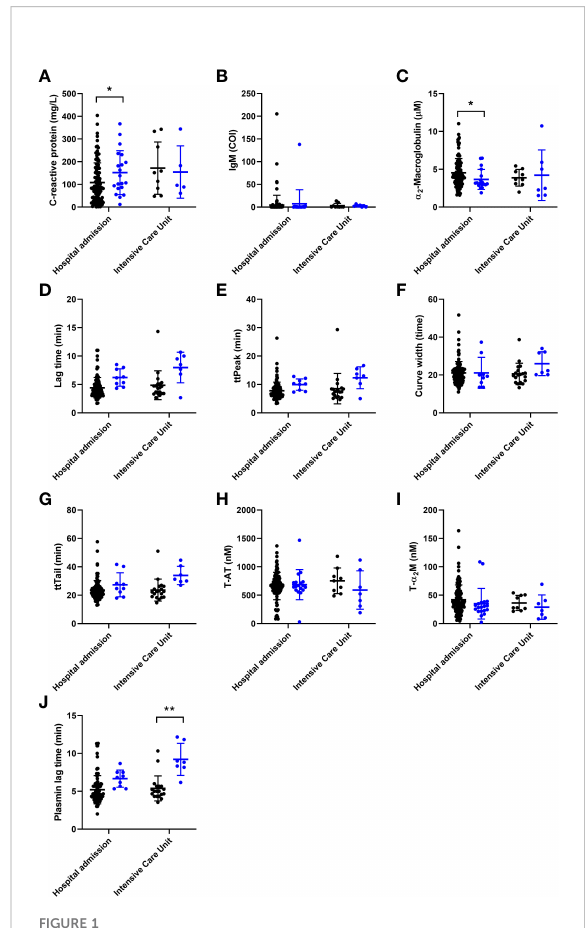
FIGURE 1 The individual association of coagulation and general (laboratory) parameters used for the development on a neural net for the prediction of thrombosis in COVID-19 patients, arranged from most to least important. Patients without thrombosis are depicted as black circles and patients with thrombosis are depicted as blue circles. (A) C-reactive protein was signi fi cantly higher in the thrombosis group of the hospital admission cohort. (B) Anti-SARS-CoV-2 IgM antibody titer did not differ between the groups. (C) a 2-macroglobulin was signi fi cantly lower in the thrombosis group of the hospital admission cohort. (D-F) The width of the TG curve, lag time and time-to-peak did not signi fi cantly different between the groups. (G-I) The time-to-tail, thrombin-antithrombin formation and thrombin- a 2- macroglobulin formation did not differ between the groups. (J) The plasmin generation lag time was signi fi cantly longer in the thrombosis group of the ICU cohort. The data are represented as mean ± standard deviation. * and ** respectively indicate a p-value smaller than 0.05 and